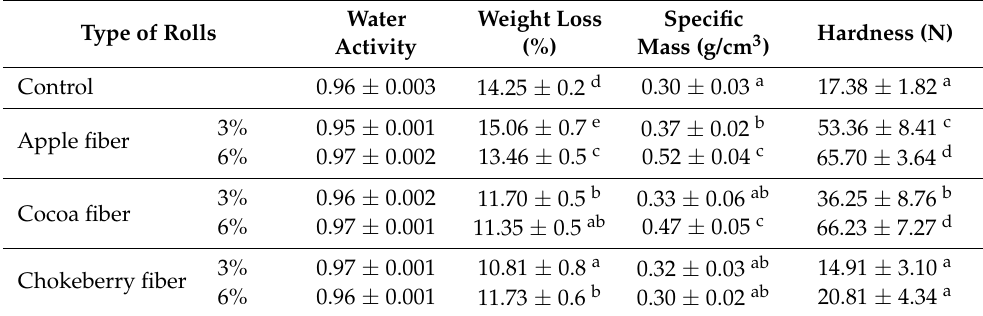
Table 5. Water activity, weight loss, specific mass and hardness of control and fiber-fortified